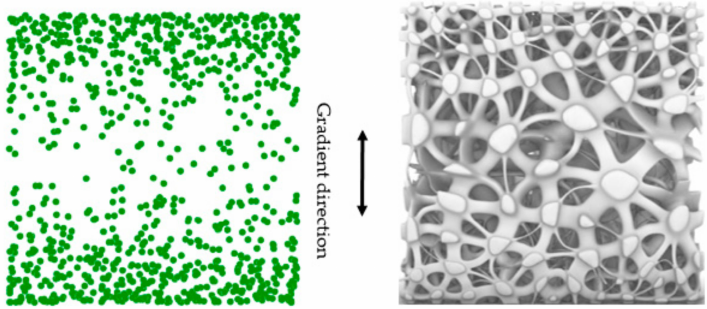
Figure 21. Structure with gradient seed and pore size in Z direction.